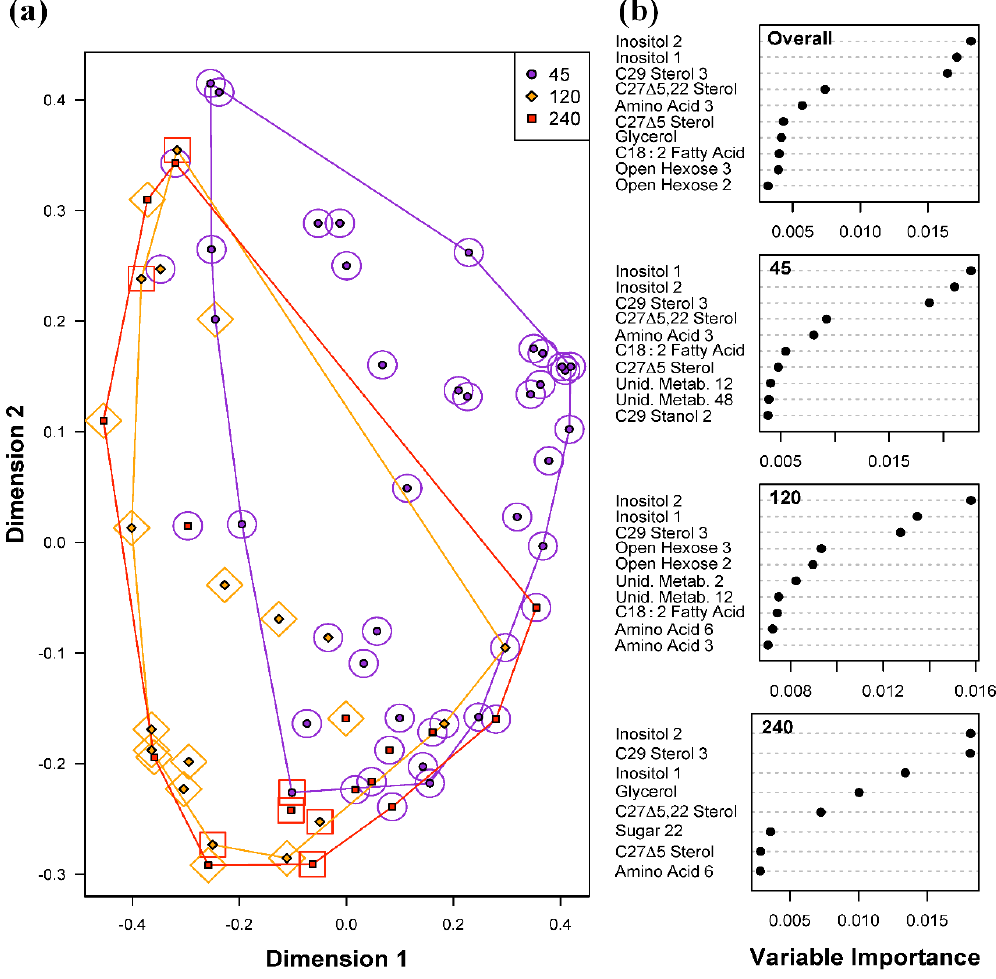
Figure 4. Random Forests classification of light intensities (45, 120 and 240 μmol photons m −20 s −1 ). ( a ) Plot of proximities of all 64 samples from 5000 Random Forests trees as projected on the first two Principal Coordinate dimensions. Color and shape of the central filled points indicate the light level the sample was cultured in (45, 120 and 240 μmol photons m −20 s −1 ), while the surrounding color and shape indicate the light intensity predicted by Random Forests. Colored lines are convex hulls linking the outermost points of each temperature; ( b ) Distribution of importance scores for the 10 most important predictor metabolites (based on mean decrease in prediction accuracy). Plot labeled “Overall” depicts metabolites found to be important for overall prediction accuracy. Other plots show metabolites important for classifying light